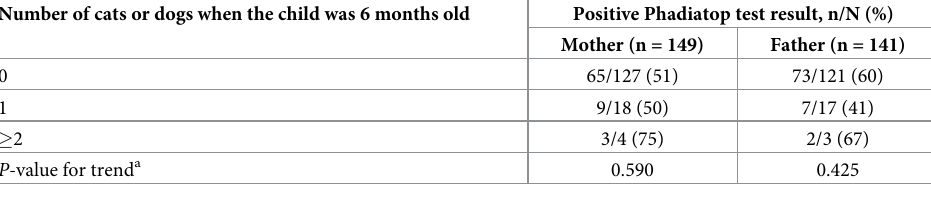
Table 3. Sensitisation in parents, measured with Phadiatop tests, in relation to the number of household cats and dogs the family had when their child was 6 months old. Number of cats or dogs when the child was 6 months